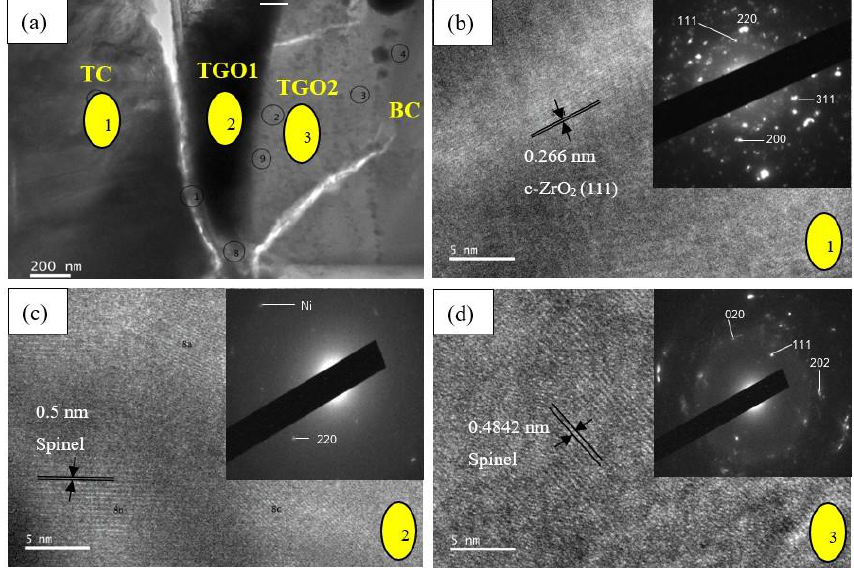
Figure 14. TEM micrograph of ( a ) TGO cross-sectional of sample A10c with interplanar distance and diffraction patterns at ( b ) topcoat, ( c ) TGO1, and ( d ) TGO2.